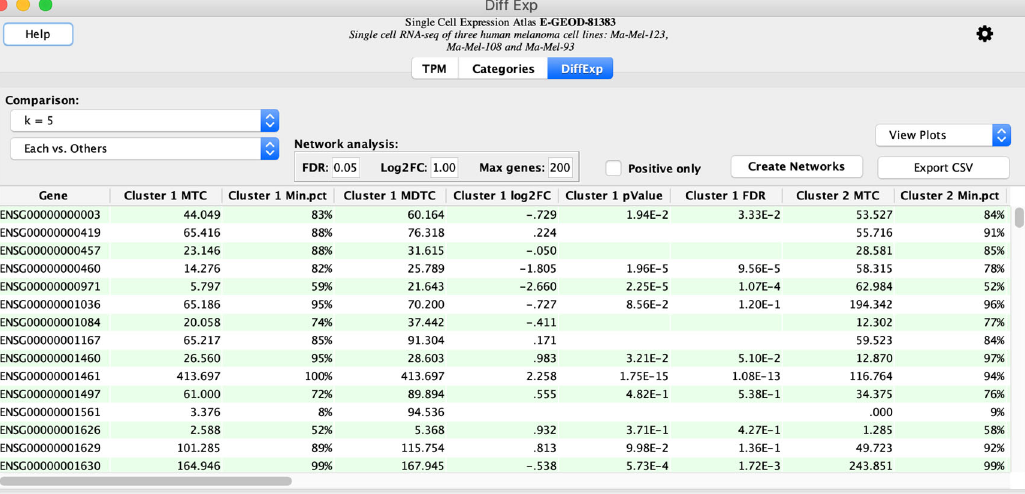
Figure 2. The DiffExp tab allows selection of cutoffs for genes to be used for network analysis and contains options for generating gene by cell heatmaps and violin plots showing gene expression distributions across cell annotation